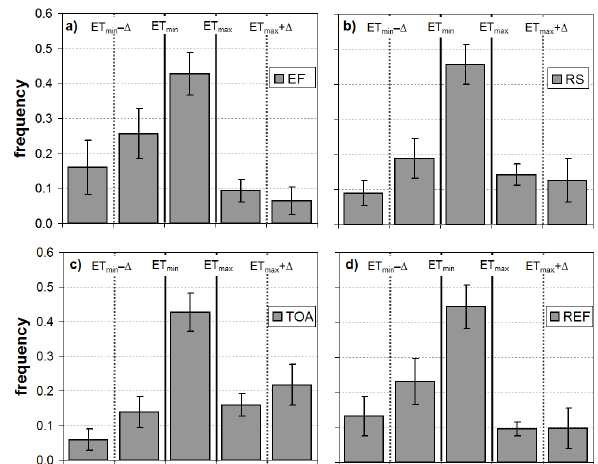
Figure 2. All-site average frequency distribution. Bars represent the average frequency of upscaled estimates from each method (com- bined over the 2 observation years) in the classes defined by vertical lines, while the error bars show the site-to-site standard deviation in frequency